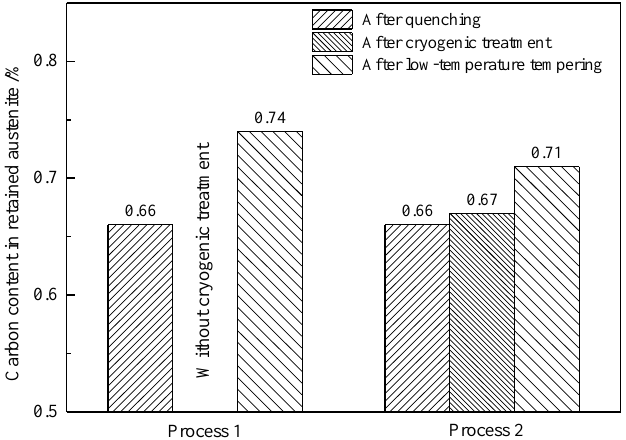
Figure 16. Carbon content of the retained austenite in the carburized layer at a 0.3 mm depth.